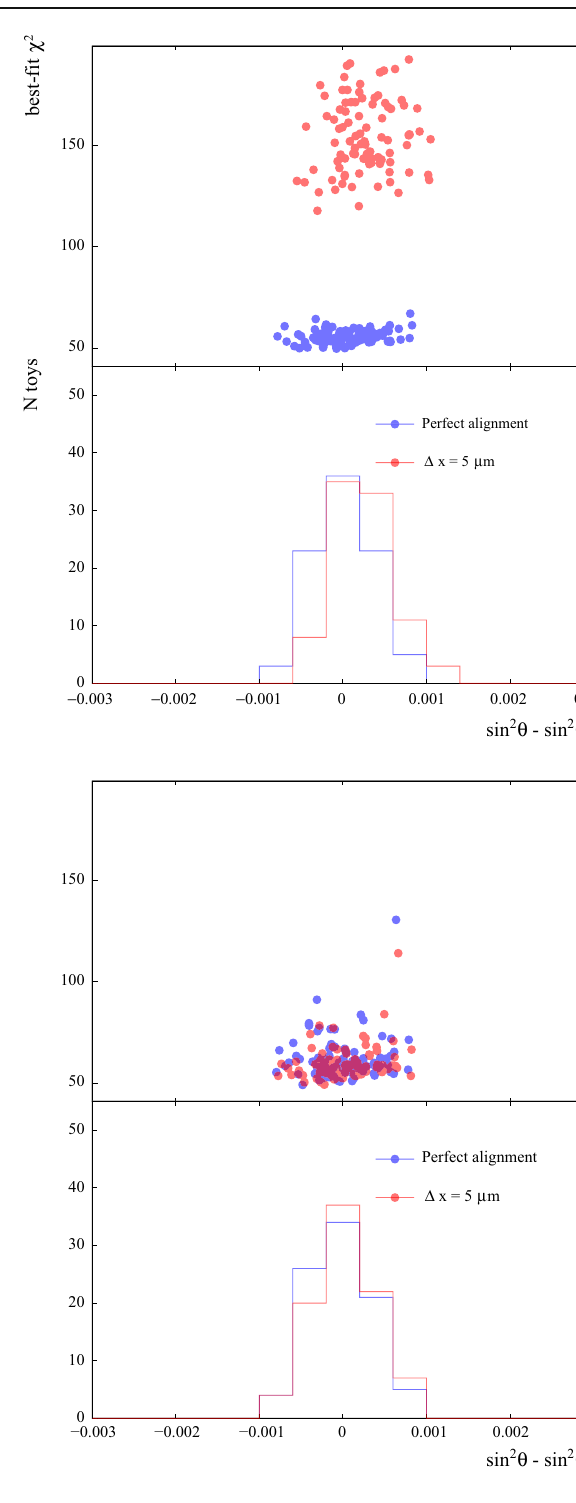
Fig. 10 The shift in the extracted (left) m W + and (right) sin 2 θ eff ueswithrespecttothereferencevalue,in90toys.Theupper(lower)row corresponds to the simulation before (after) application of the pseudo- mass method. The distributions drawn with blue lines are obtained from unbiased data. Those with red lines are obtained from toy data with a